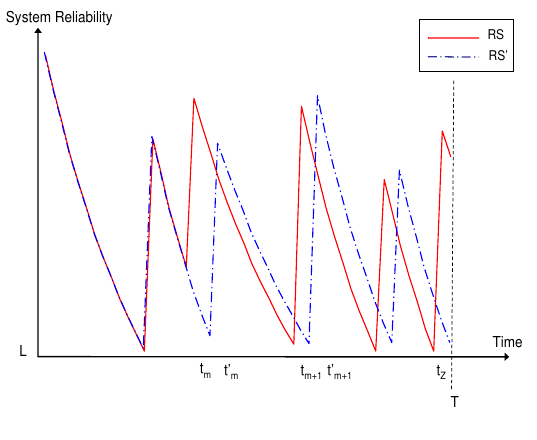
Fig. 2. An example for RS and